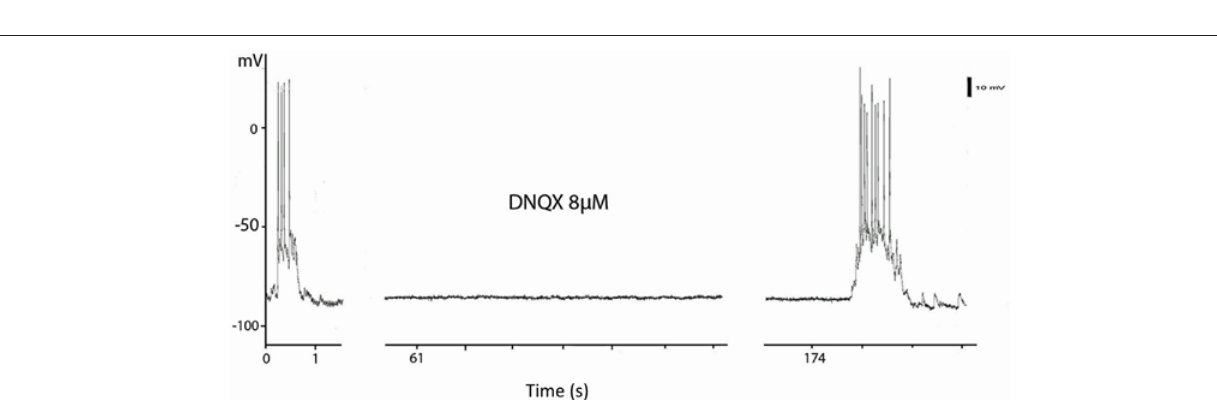
Figure 6 | Blockade of uP states by blockade of AMPA receptors The current clamp records are taken from a continuous record of a striatal neuron in a mixed corticostriatal culture. The culture was treated with artificial CSF containing 8 μM DNQX for 1 min and the bursts were abolished for the next 2 min. The first burst of the recovery is shown at 174 s after